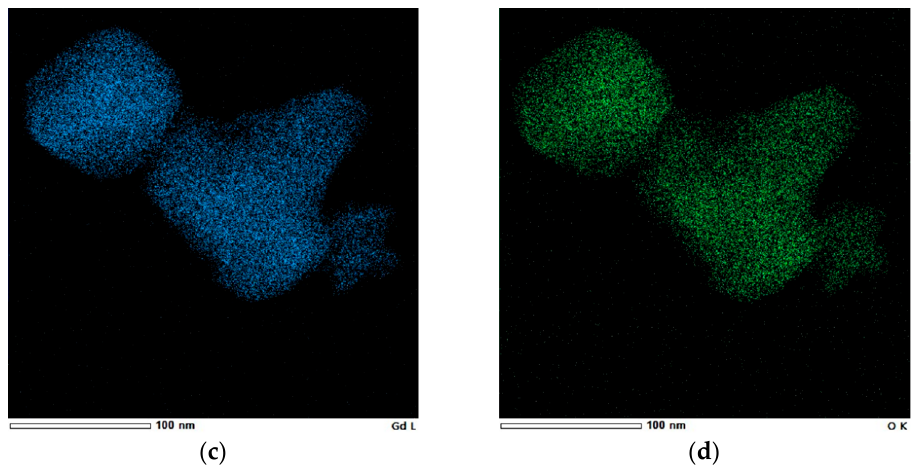
Figure 9. ( a ) Bright-field STEM image and elemental mapping confirming the presence of ( b ) Eu, ( c ) Gd, and ( d ) O in the Gd 2 O 3 :Eu 3+ nanoparticles.